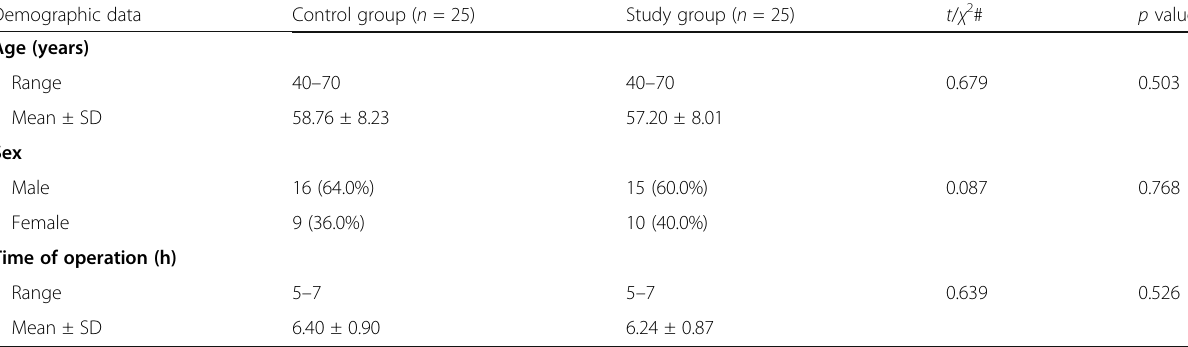
Table 1 Demographic data